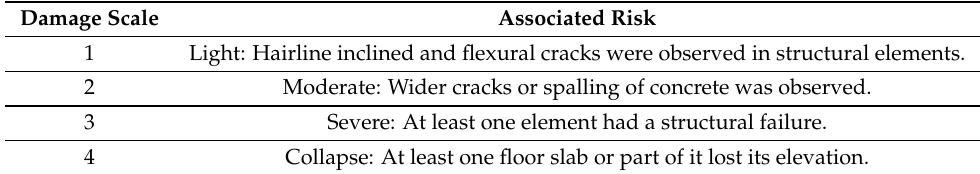
Table 3. Damage scale for selected earthquakes (adopted from [40,43]).